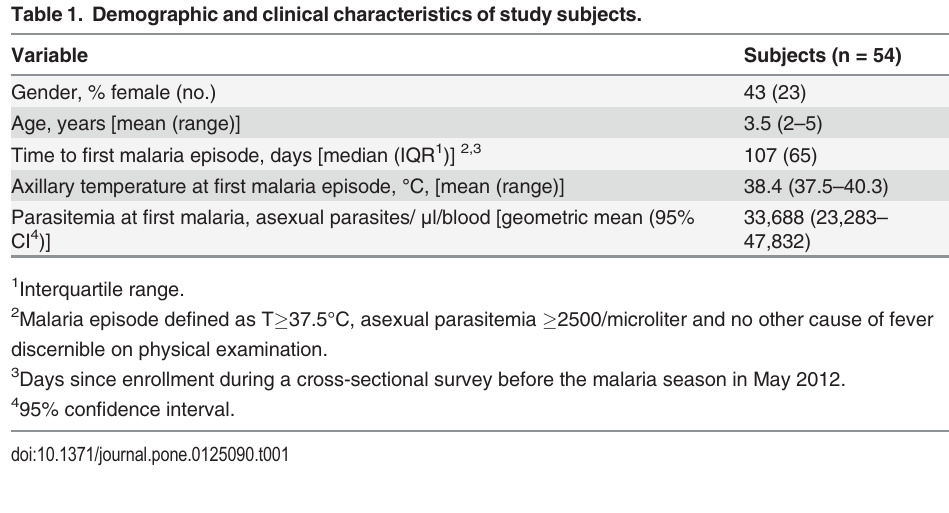
Fig 5. Kinetics of vaccine-specific IgG levels in children during the dry season and after acute malaria. (A) The study was designed to take advantage of the sharply demarcated and intense 6-month malaria season (July — December) and 6-month dry season (January — June; negligible malaria transmission) in Mali. Shown is the number of febrile malaria episodes per day over two years at the study site in a cohort of 695 children and adults. (B) IgG levels specific for routine vaccines administered under one year of age (tetanus, measles and Hepatitis B) were measured in plasma collected from 54 children at four time points (vertical arrows): before and after the 6-month dry season, 10 days after the first acute malaria episode of the ensuing malaria season, and after the second dry season. Shown for each subject are IgG titers specific for (C) tetanus, (D) measles and (E) hepatitis B vaccines at the time points indicated in (B) . The x-axis indicates the age at which the respective time points occurred for each subject. In red are subjects who experienced an accelerated decline in vaccine-specific IgG titers following acute malaria (between 2 nd and 3 rd time points) relative to each child ’ s own rate of change during the preceding dry season (between 1 st and 2 nd time points). The percentage of subjects for whom malaria was associated with an accelerated decline in IgG is shown in red text for each vaccine. A linear mixed effects model that included three time points over 18 months (before and after the first dry season, and after the second dry season) was used to estimate average IgG half-lives for all subjects (black dashed line) and separately for children aged (cid:3) 3 years (green dotted line) and > 3 years of age (blue dash-dot line).